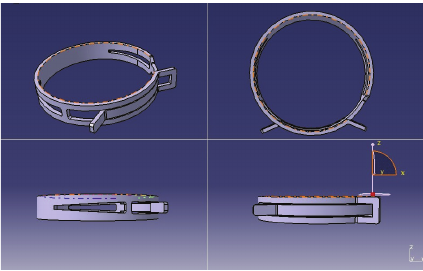
Figure 1: Images with various lighting illumination pattern.